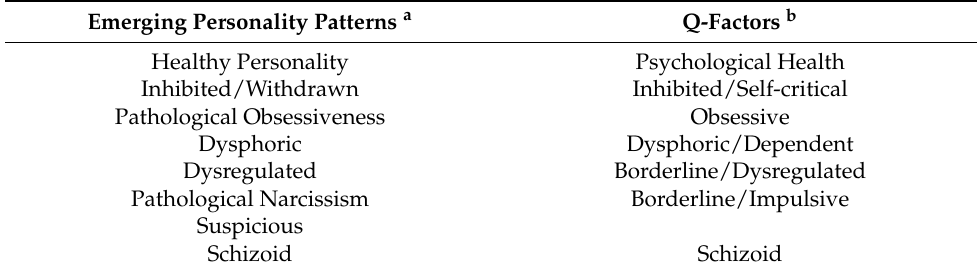
Table 8. Comparison between emerging personality patterns and